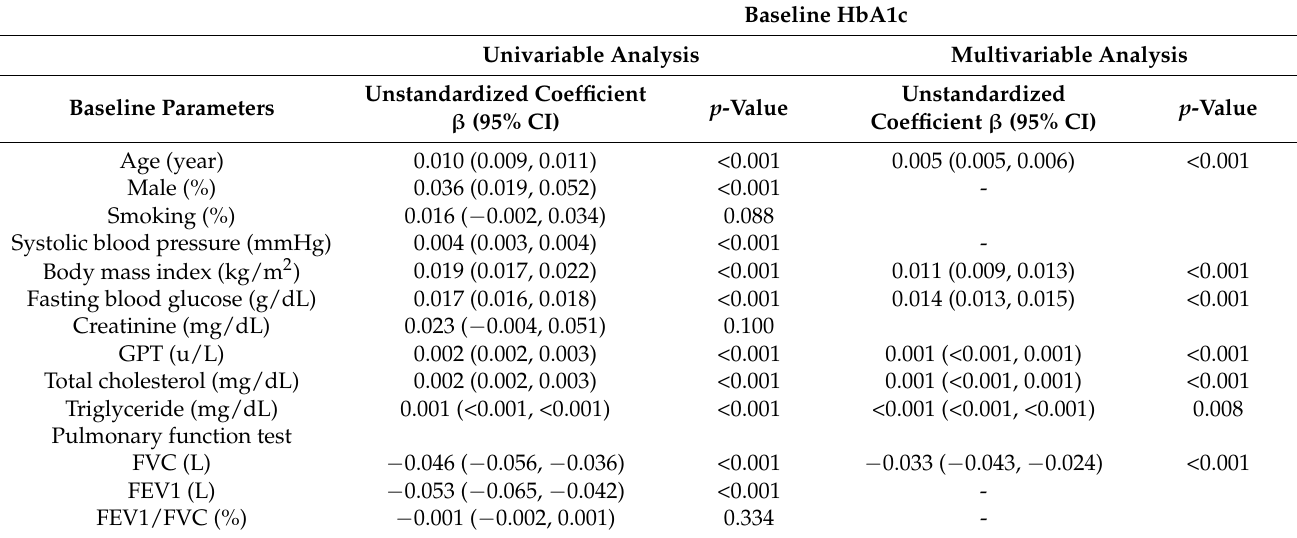
Table 2. Univariable and multivariable linear regression analyses for baseline HbA1c.